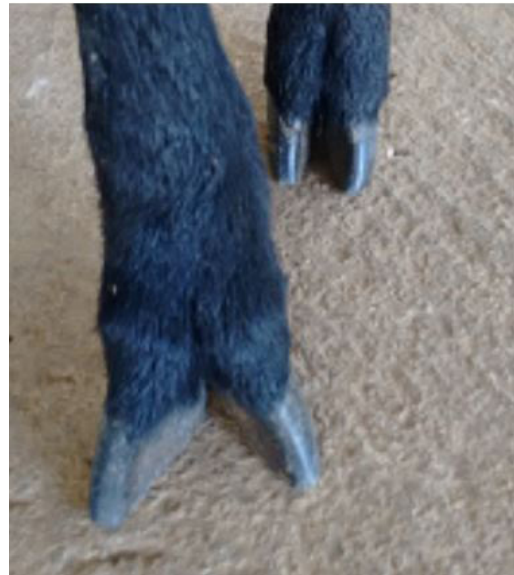
Figure 13. Functional right thoracic limb showing spacing between digits, probably due to the additional weight of the accessory